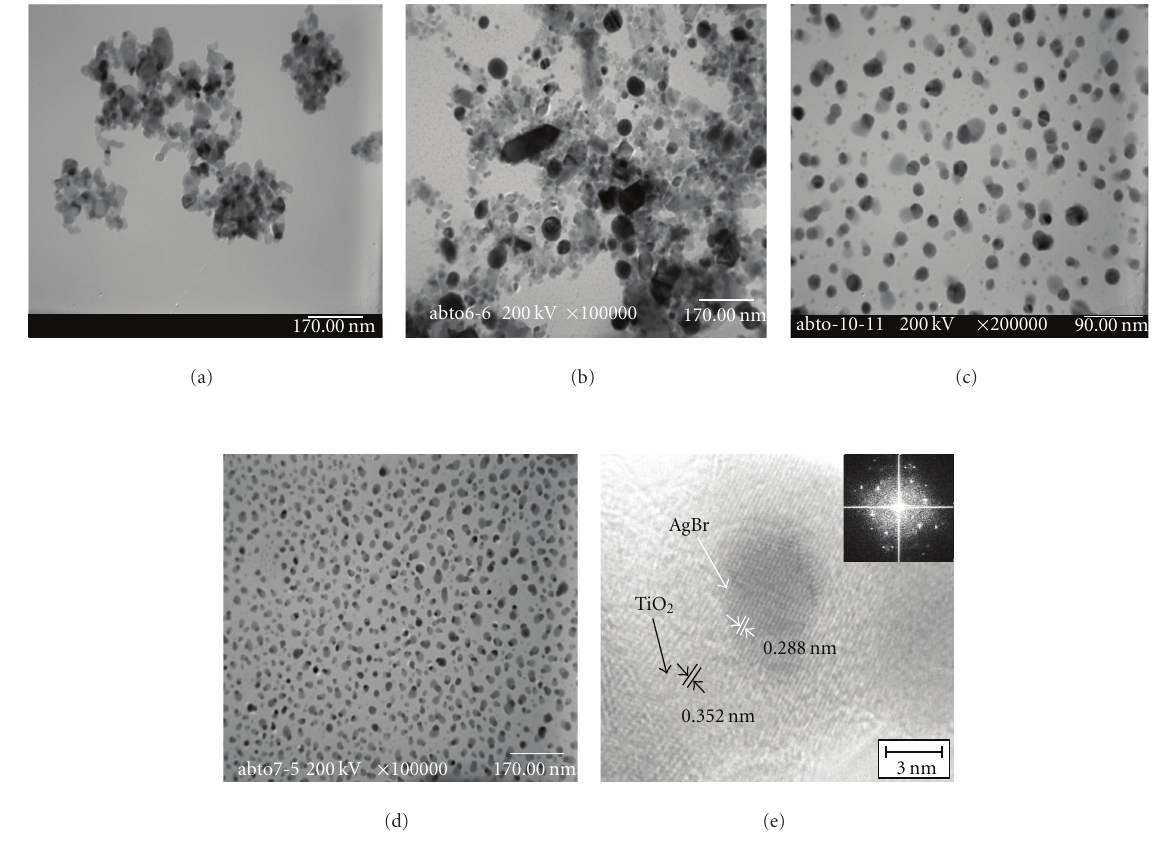
/m P25 (a) 3.35; and AgBr/TiO 2 with 3